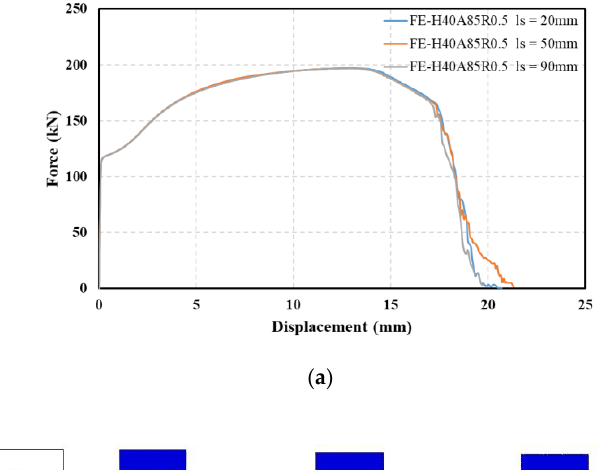
Figure 23. ( a ) Load – displacement curves and ( b ) failure modes of specimens with different solid areas.